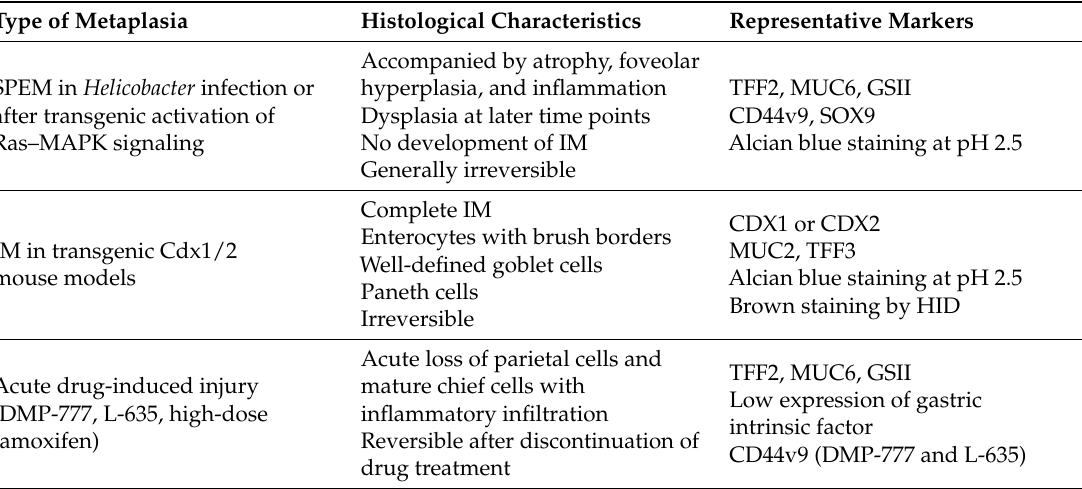
Table 2. Characteristics of mouse models of stomach